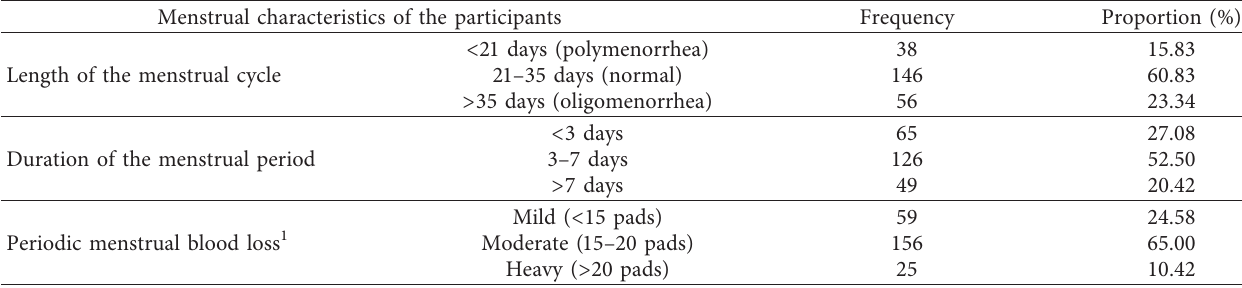
Table 2: Menstrual characteristics of study participants. Menstrual characteristics of the participants